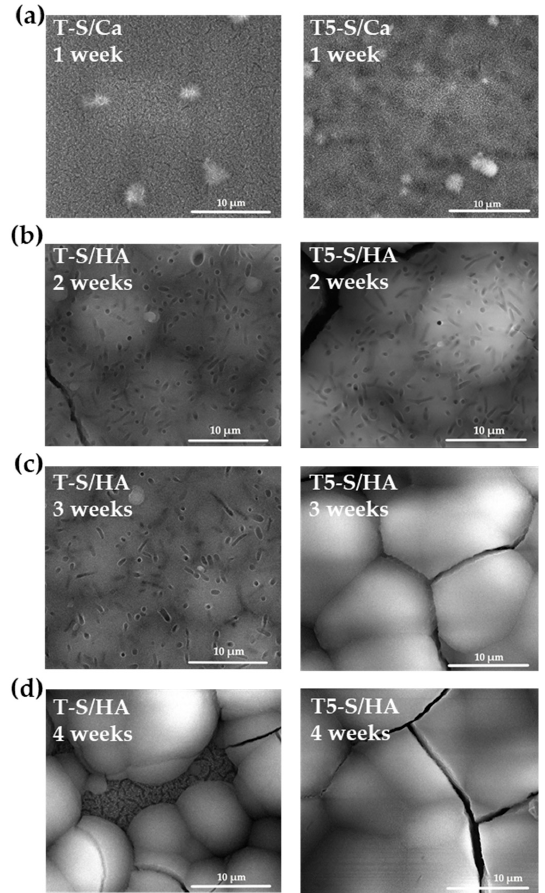
Figure 4. Scanning electron microscopy (SEM) images of substrates of T-S and T5-S with CaTiO 3 (Ca) or hydroxyapatite (HA) layers after immersion in SBF for 1 ( a ), 2 ( b ), 3 ( c ), and 4 ( d ) weeks.